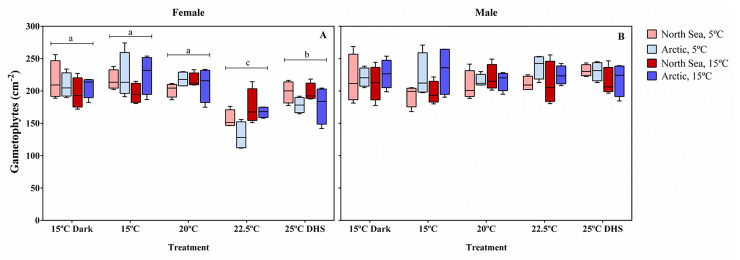
Female and male gametophyte survival after recovery.Female (A) and male (B) gametophyte densities from the North Sea and Arctic populations of Laminaria digitata after 27 days of recovery at 5°C and 15°C from different treatments (15°C dark, 15°C, 20°C, 22.5°C and 25°C DHS). Box plots with median, boxes for 25th and 75th percentiles and whiskers indicating min and max values (n = 4). Different letters indicate significant differences among means for each treatment. See Table 4 for statistics.